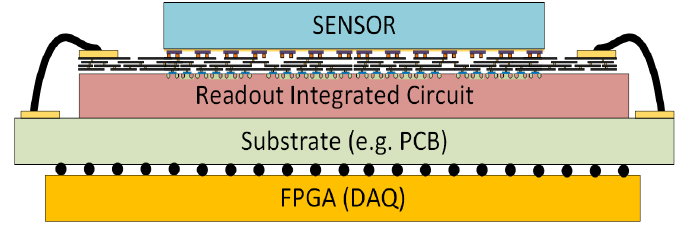
Figure 1. Detector system consisting of a sensor bonded to a ROIC and communicating with a data acquisition system such as an